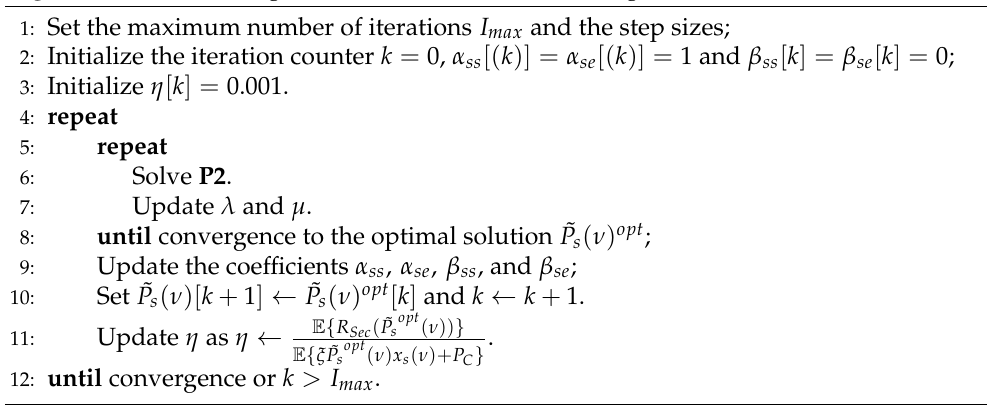
Algorithm 1 Iterative ergodic secure EE maximization